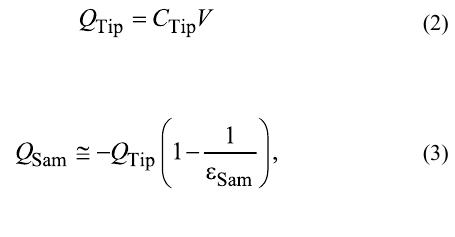
phase contrast of the sample compared to the mica substrate as a function of different tip biases ranging from − 12 V to 12